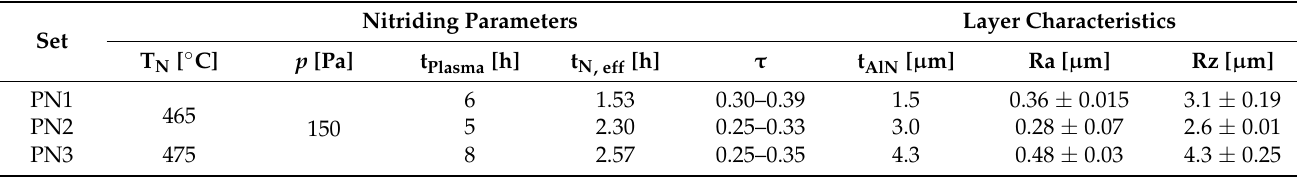
Table 2. Parameter sets of plasma nitriding (T N . . . nitriding temperature; p . . . pressure; t Plasma . . . plasma-on-time; t N, eff . . . effective nitriding time; τ . . . pulse-pause ratio) and important values for characterizing the AlN layer generated (t AlN . . . layer thickness; Ra . . . mean roughness; Rz . . . the average surface roughness). Layer